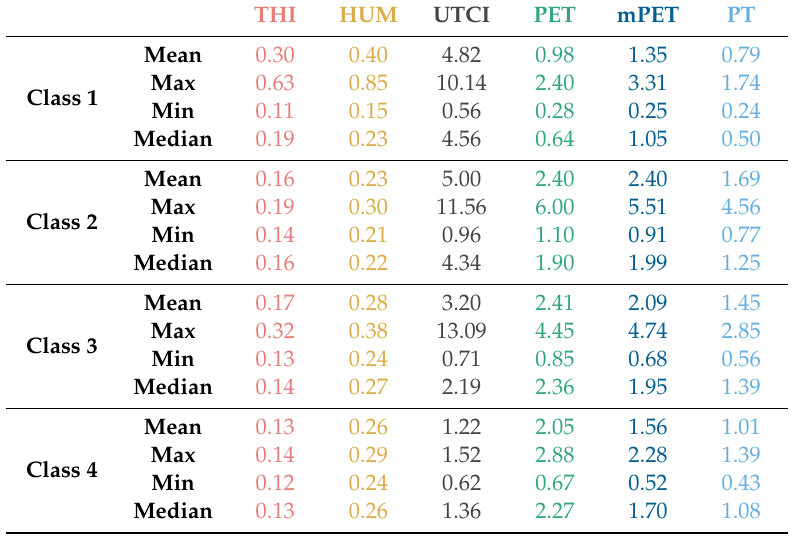
Table 9. Descriptive statistics of the indices’ sensitivity to WS change rates under di ff erent GR conditions.